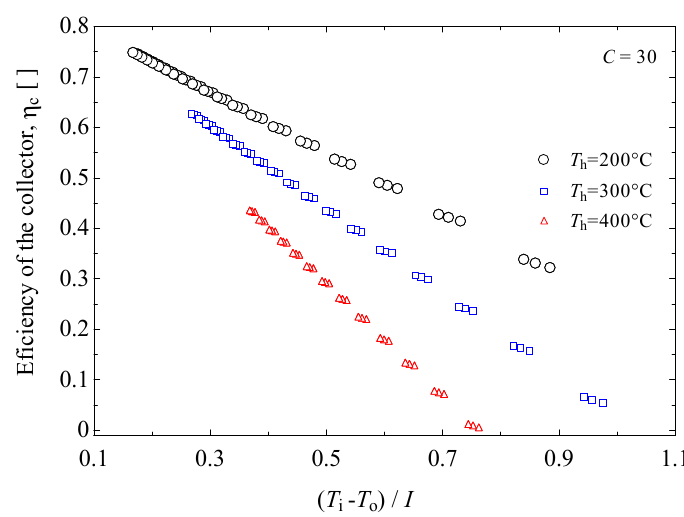
Figure 9. Efficiency of the solar concentrator with respect to ( T i − T o )/ I at 3 hot spot temperatures. Figure 9. E ffi ciency of the solar concentrator with respect to ( T i − T o ) / I at 3 hot spot temperatures.